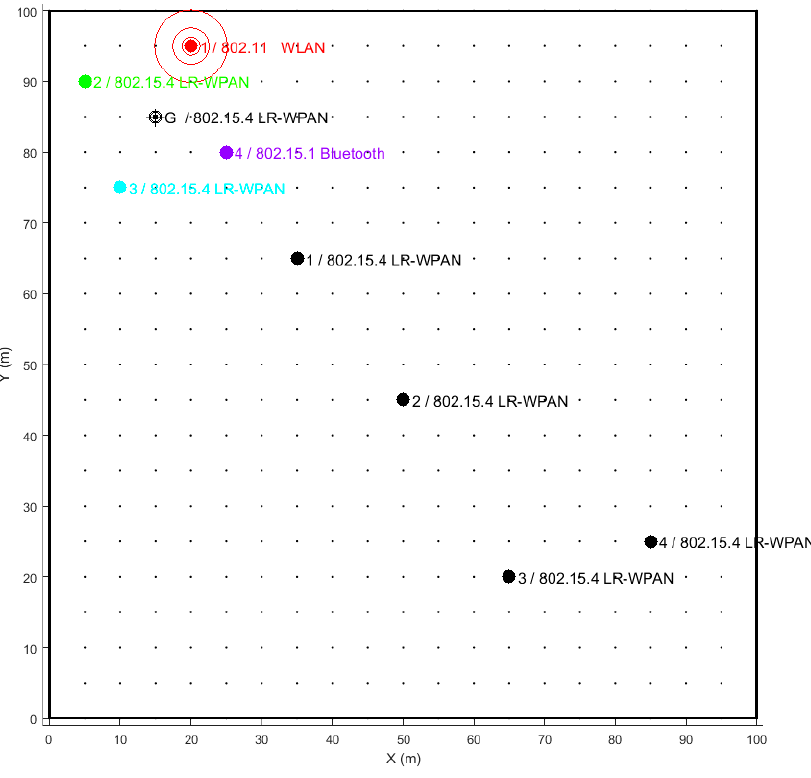
Figure 17. Example of an 802.15.4 network deployment with four nodes (black dots) and a gateway (G). The gateway is surrounded by four interfering networks (coloured markers).